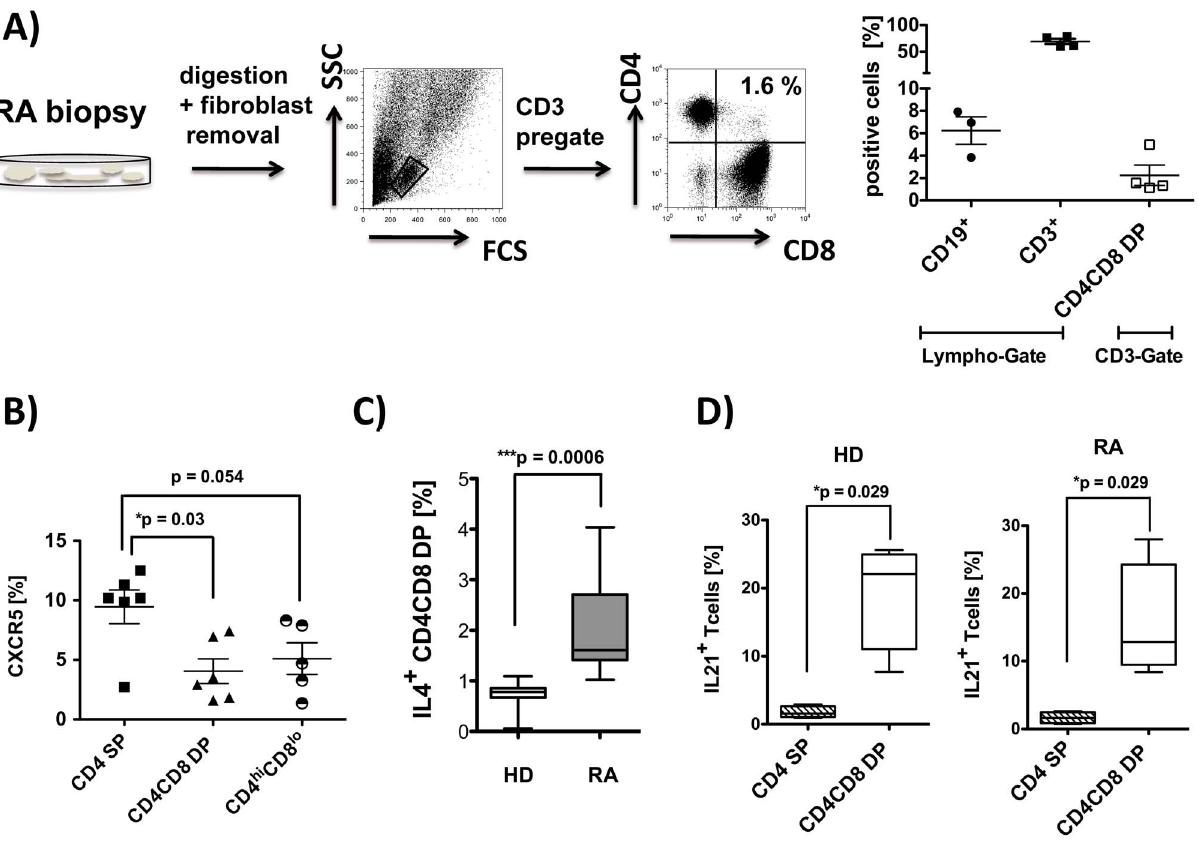
Figure 4. CD4CD8 double positive T cells are present in the synovium of RA patients and produce T helper 2 like cytokines. A) Single cell suspensions were prepared from synovial biopsies from RA patients (n=4) and analyzed by flow cytometry using anti-CD19, anti-CD3, anti-CD4 and anti-CD8 monoclonal antibodies (PI staining used for exclusion of dead cells). Representative FACS plots are depicted. Each data point represents one experiment. B) PBMCs from RA patients (n=6) were isolated and FACS analysis from live cells were performed (PI staining used for exclusion of dead cells). Cells were pre-gated on CD3 + T cells, and CXCR5 expression was analyzed in the subpopulation indicated. C) PBMC were stimulated in vitro for 4 hrs with Cytostim. Subsequently, an IL-4 specific secretion assay was performed, and expression of CD4 and CD8 was determined in vital cells (PI staining used for exclusion of dead cells) pre-gated on CD3. Percentage of IL-4 producing CD4CD8 double positive T cells in HD (n=7) and RA patients (n=8) is given. D) PBMCs from HD (n=4) and RA (n=4) were stimulated with PMA/Iono for 4 hrs, and intracellular staining for IL-21 was performed. Cells are counterstained with anti-CD3, anti-CD4 and anti-CD8. Depicted is the percentage of cytokine producers in total CD4CD8 DP T cells and in CD4 SP cells. Box plots in C) and D) show median, interquartile range, and 10–90 percentiles. Significance as given, *p ,